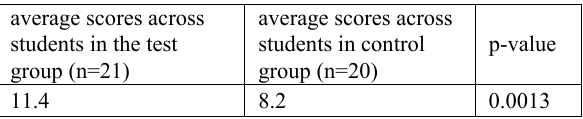
Table 1. Average scores across students in test and control